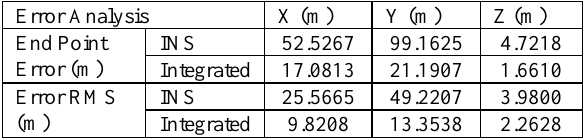
Table 5. Analysis for position errors